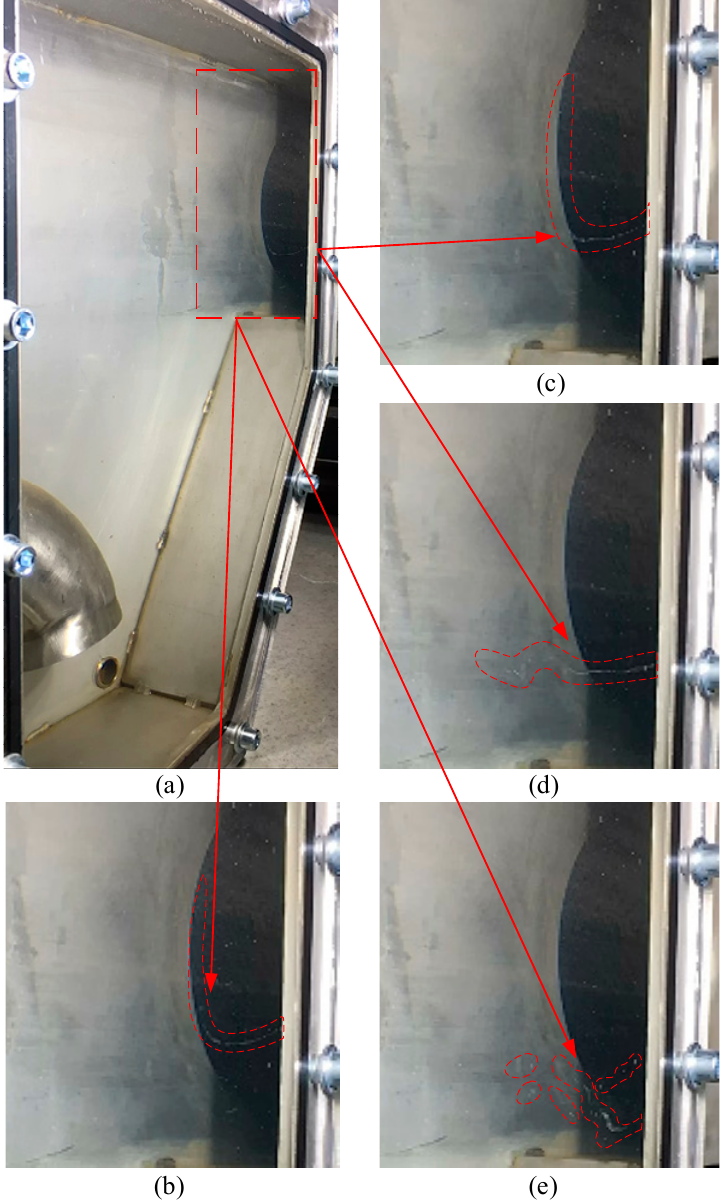
Figure 7. The evolution process of the sub-surface vortex in the primary pump intake. ( a ) Pump 3 inlet, ( b – e ) sub-surface vortex sucked downstream to the inlet of pump 3.